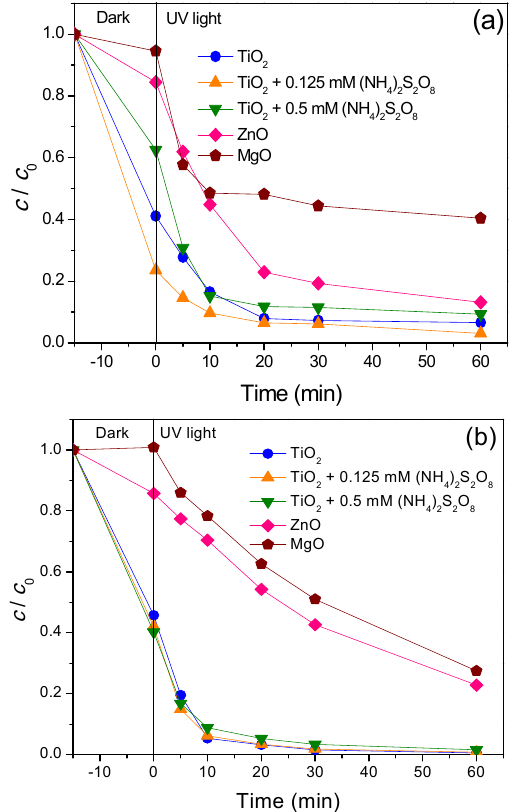
Figure 7. Removal of antibiotics ( a ) CIP and ( b ) CEF (0.05 mM) from water using different catalysts (0.5 mg/mL) in the presence/absence of (NH 4 ) 2 S 2 O 8 under UV light.